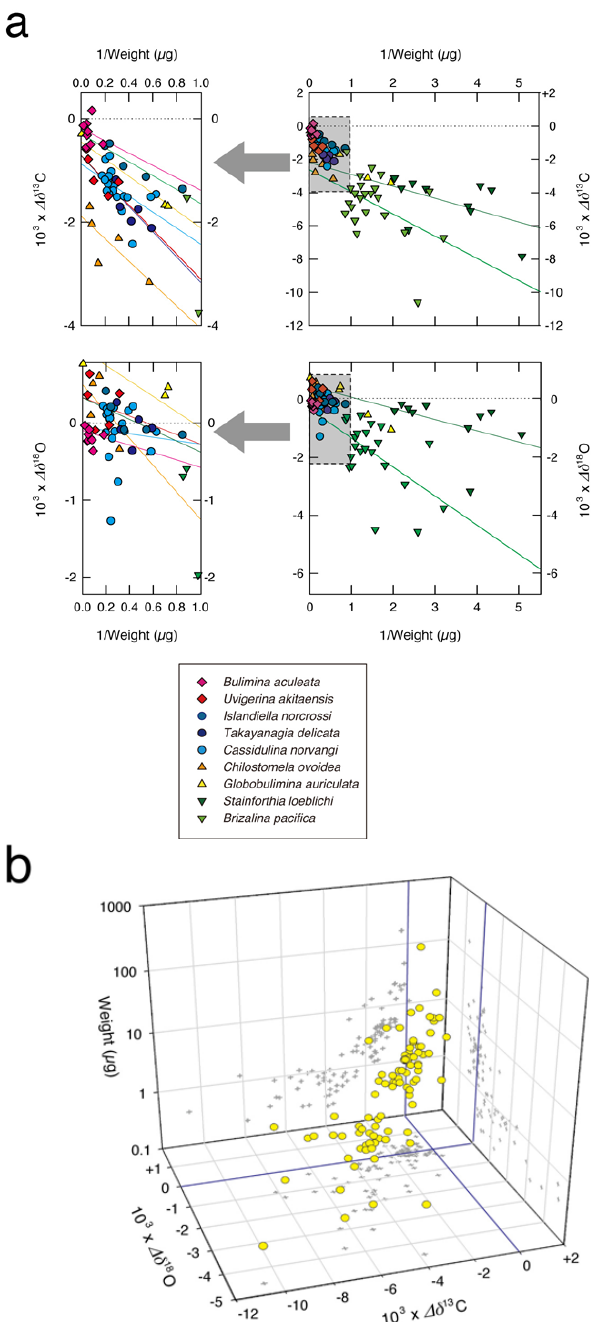
Fig. 5. Relationship between shell weight and 1δ 13 C and 1δ 18 O values of individual benthic foraminifera. (a) 1δ 13 C and 1δ 18 O values of all individual benthic foraminifera analyzed plotted as a function of inverse shell weight. Lines are linear regressions fitted to each species. (b) Three-dimensional plot of 1δ 13 C, 1δ 18 O, and shell weight (animation available as Supplement Fig. 1).